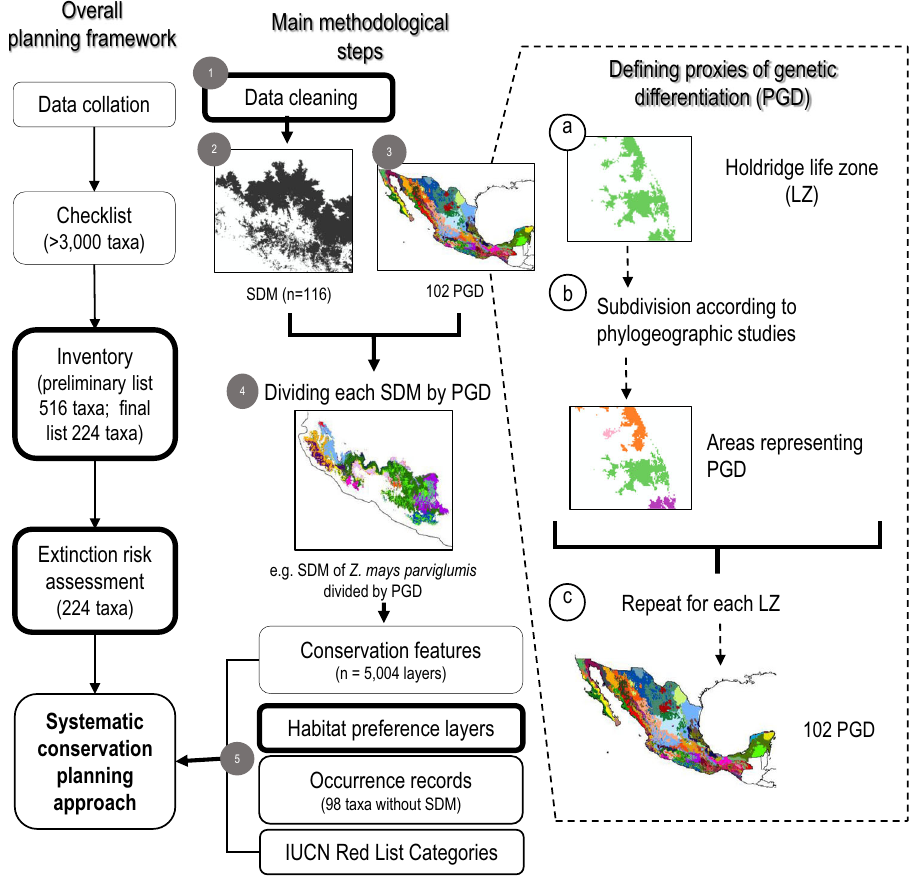
Fig.1|Generalwork fl owoftheproject “ SafeguardingMesoamericancropwild relatives ” . Overall stages of the planning framework are shown at the left, and the main methodological steps to the right, including an approach to incorporate infraspeci fi c genetic variation in a spatially explicit way. (1) Information, including data on occurrences, extinction risk, economic or social aspects, among others of taxa listed in the Mesoamerican CWR inventory was collated and cleaned. (2) Species distribution models (SDM) for 116 taxa were obtained. (3) In parallel, proxies of genetic differentiation (PGD) were generated for Mexico, integrating environmental and historical drivers of differentiation. For this, ( a ) Holdridge life zones (accounting for environmental variability) were ( b ) subdivided into areas thatcouldbepotentiallyisolatedduetohistoricalprocesses(usingcartographyon biogeographic provinces, edaphology, and watersheds) based on a literature